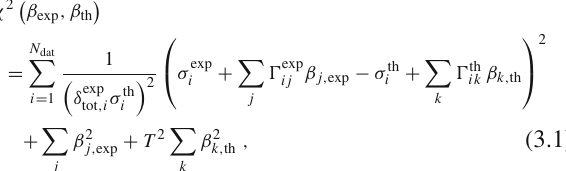
the results of profiling with the top differential distributions at TeV with f corr = 0 . 25 (left) and the W + charm rapidity distribution at √ s = 13 TeV with f corr = 1 (right plot). A tolerance factor of T = 1 has been used for this specific